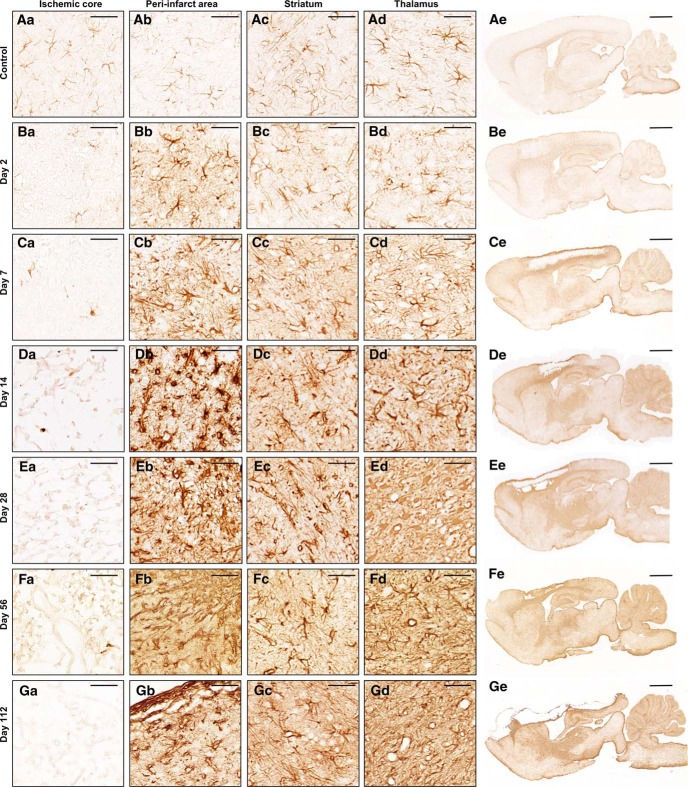
Time course of astrocyte activation after cortical stroke. Representative images of immunostaining for astrocytes (GFAP) from the ischemic core (a), peri-infarct area (b), striatum (c), and thalamus (d) at 2 (B), 7 (C), 14 (D), 28 (E), 56 (F), and 112 (G) days after 90-min dMCAo in sagittal rat brain paraffin sections. Control images (A) are from the contralateral hemisphere of the stroke brain. Scale bar is 50 µm in high-magnification images and 2000 µm in low-magnification images. The regions analyzed (a–d) are shown in more detail in Fig. 2O.